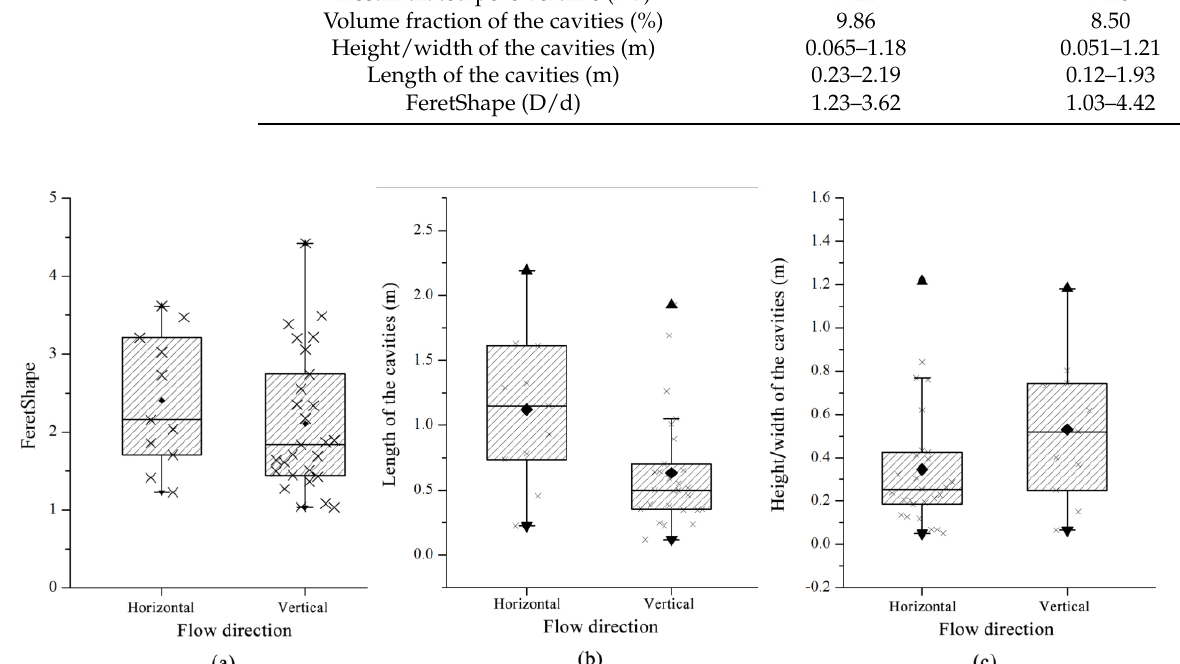
Figure 16. Comparison of the characteristic parameters of the pore shape for different seepage directions. ( a ), ( b ), and ( c ) represent the statistical results of FeretShape, length of cavities, height/width of cavities with different flow directions, respectively.